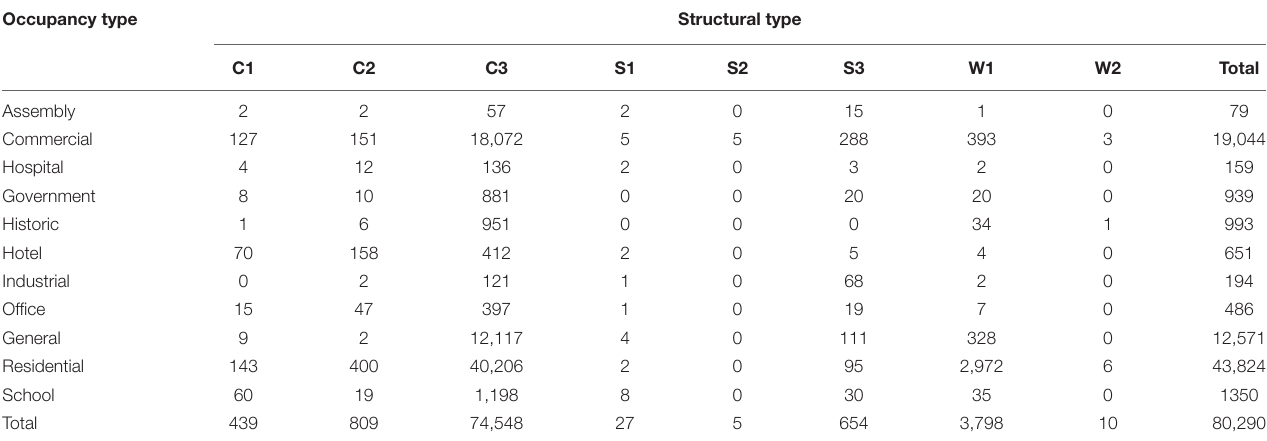
TABLE 1 | Building information in Chiang Mai Municipality.